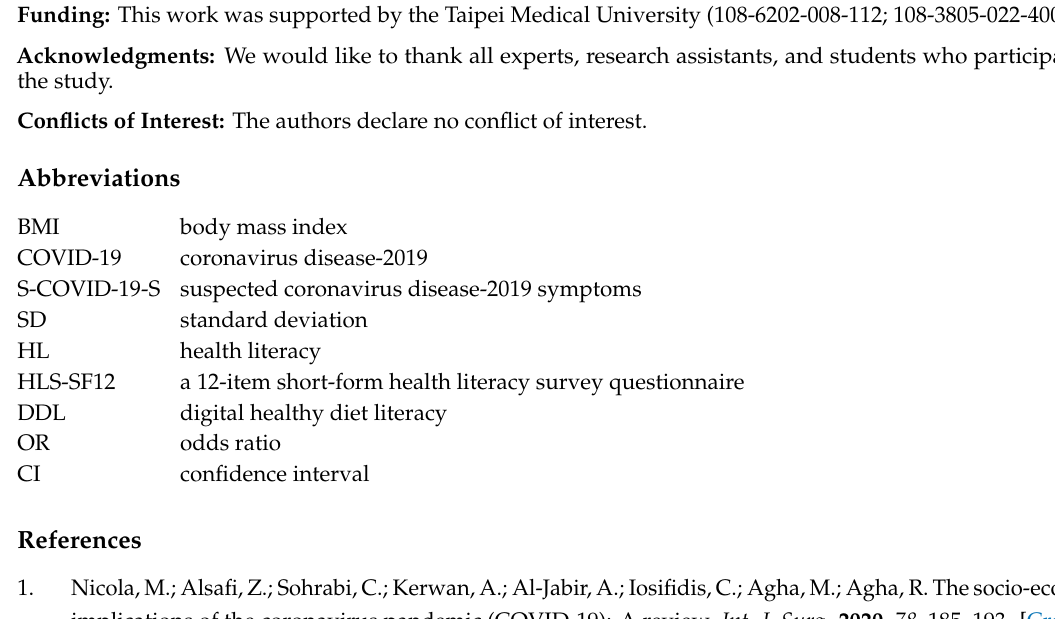
Table S1: Spearman’s correlation among the studied variables ( N =